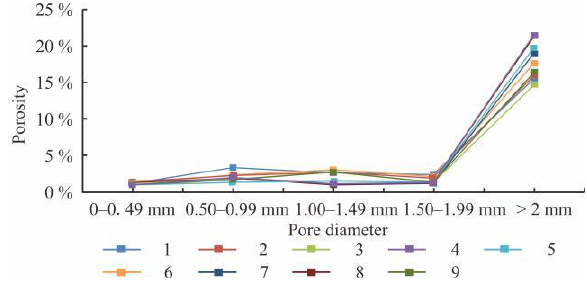
Figure 13. Porosity of each section.